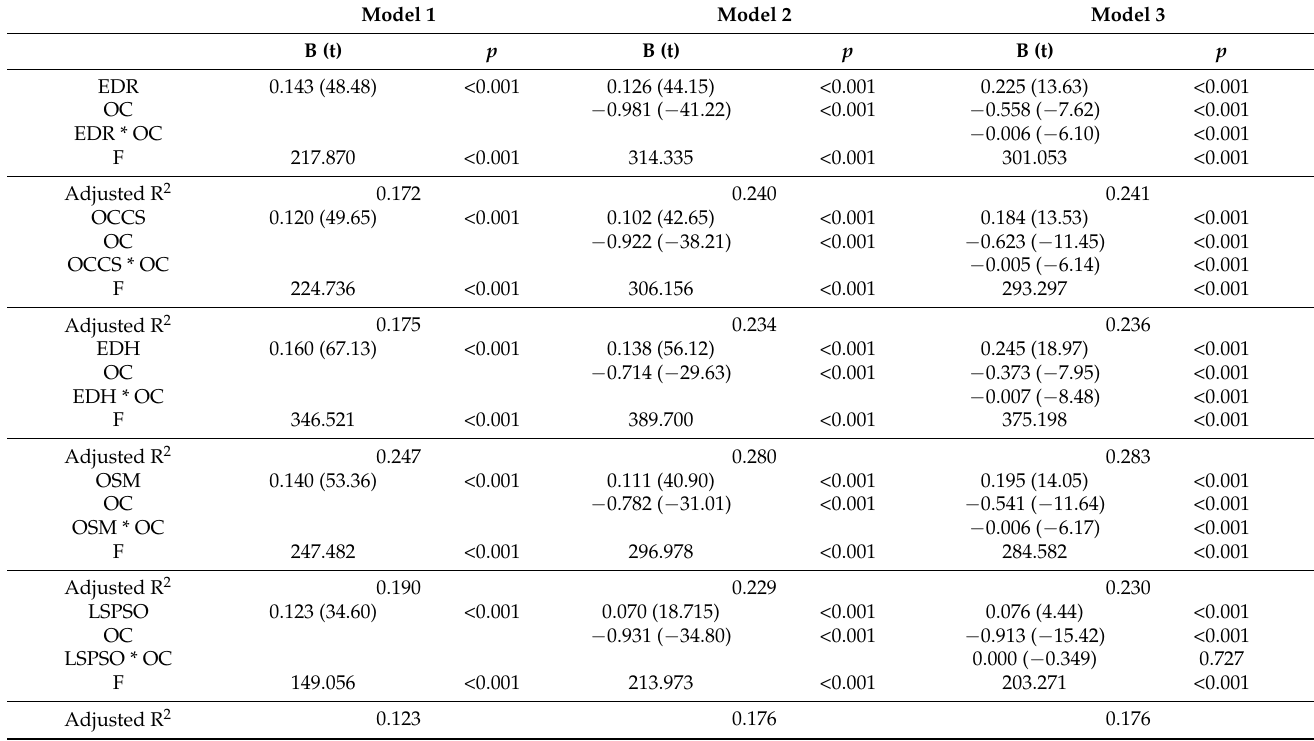
Model 1: Adjustment for gender, age, education, shift work, main duty, and working period. Model 2: Adjustment for Model 1 + organizational climate. Model 3: Adjustment for Model 2 + organizational climate * occupational climate (interaction term). EDR: Emotional demands and regulation, OCCS: Overload and conflict in customer service, EDH: Emotional disharmony and hurt, OSM: Organizational surveillance and monitoring, LSPSO: Lack of a supportive and protective system in the organization, OC: Organizational